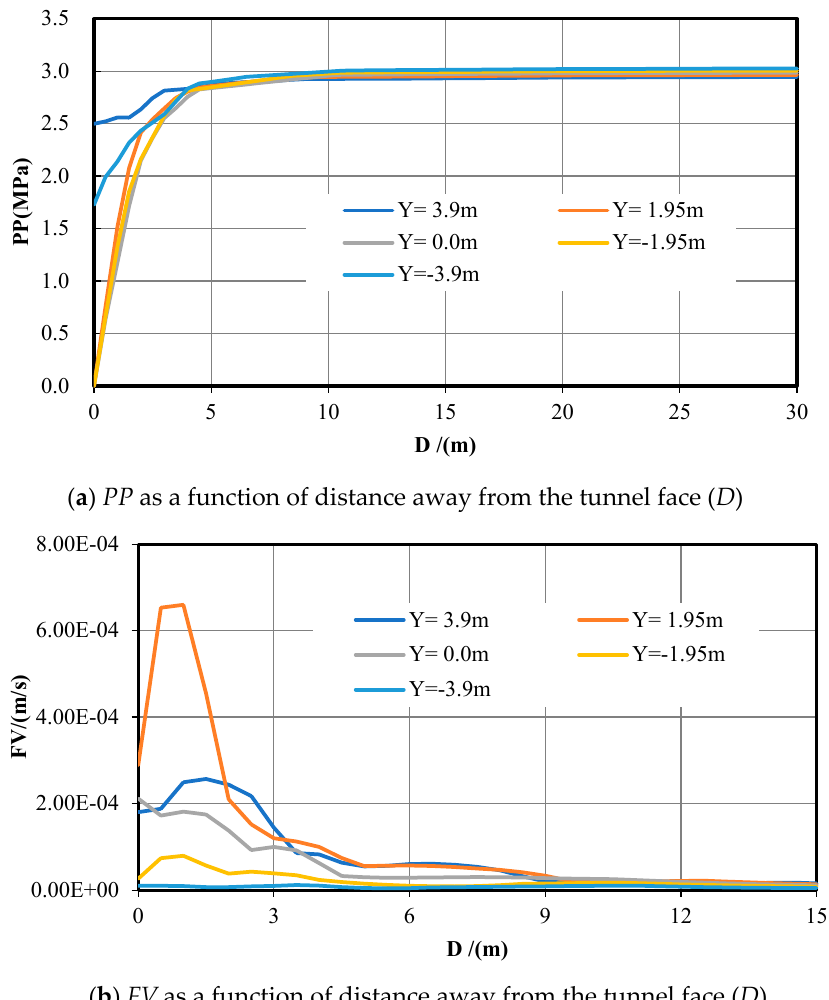
Figure 5. Pore pressure and flow velocity within 30 m ahead of the tunnel face as a function of distance away from the tunnel face (Y = 20 m).